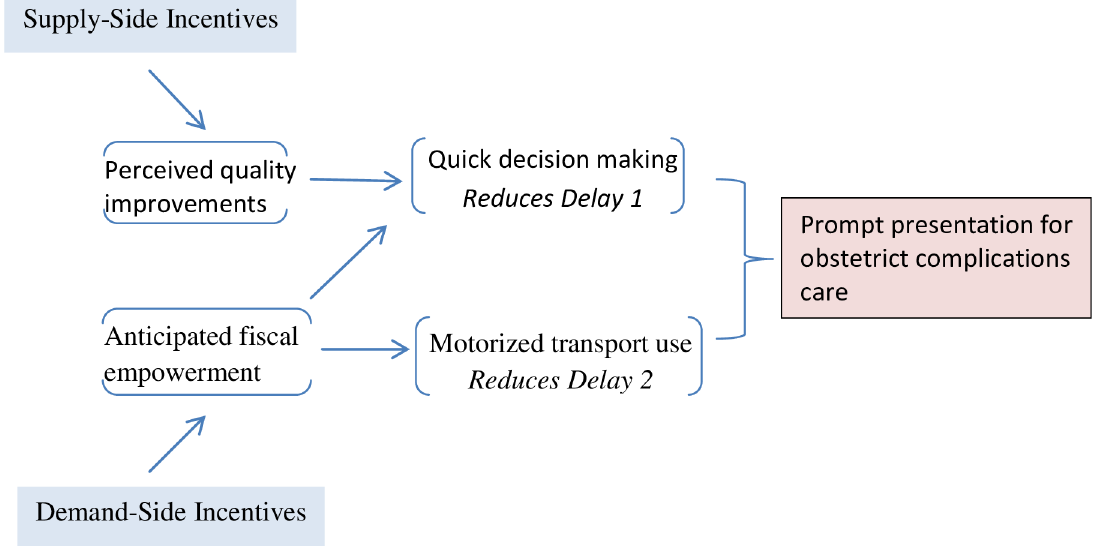
Fig 2. Conceptual frameworkdepicting the association between Supply-Side Incentives, Demand-Side Incentives and prompt presentation for obstetric complications care.